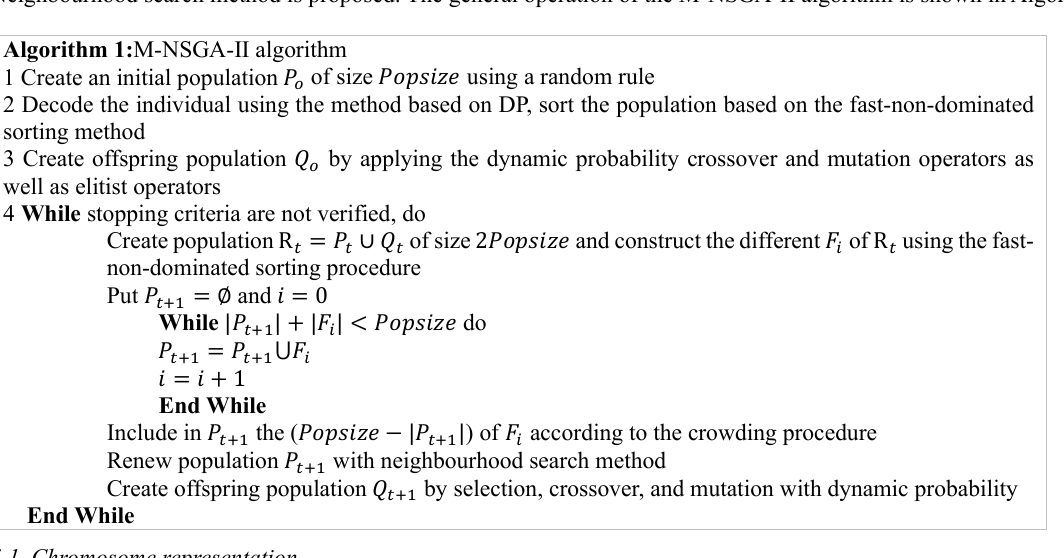
Algorithm 1: M-NSGA- Ⅱ algorithm